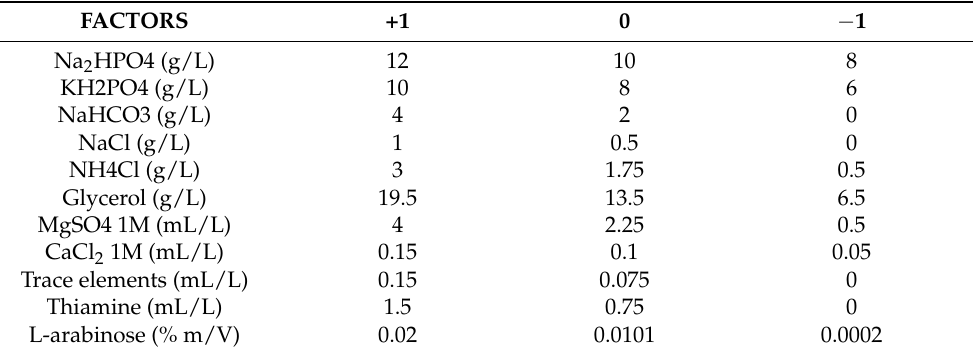
Table 1. Medium factors and the levels used in Plackett-Burman design (PBD). The factor levels are described as central (0), higher (+1) and lower (–1 ). The studied combinations of the medium factors are included in Supplementary Material Table